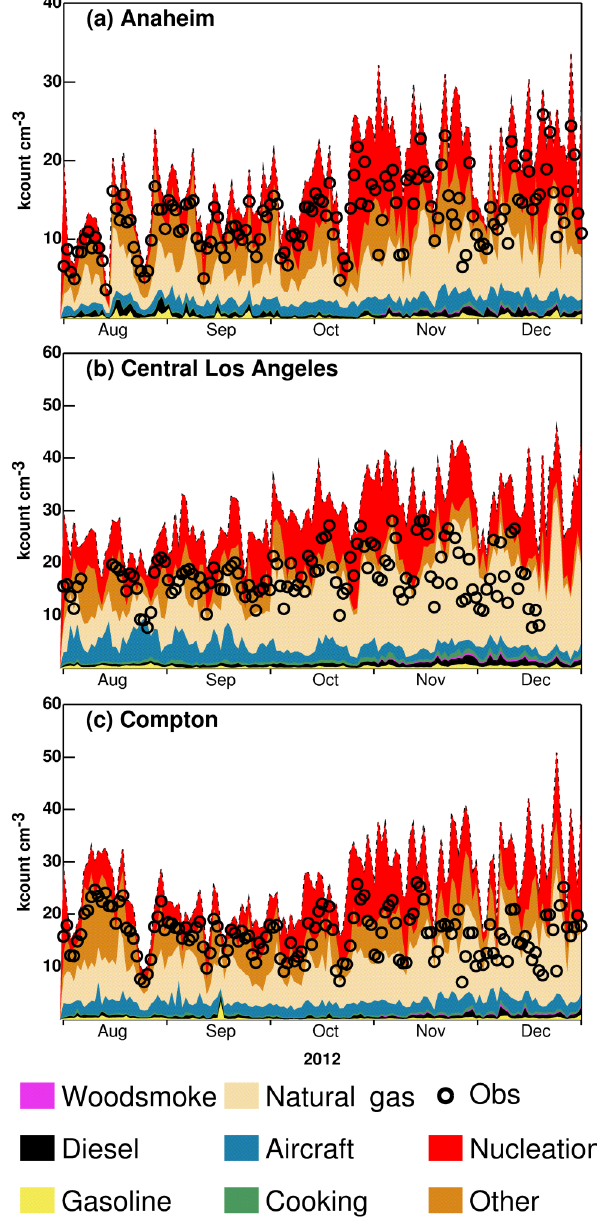
Figure 8. Seasonal variation of measured N 7 (black circles) and major source contributions to best-fit N 10 at Anaheim, central LA, and Compton, respectively. Results within each month have daily time